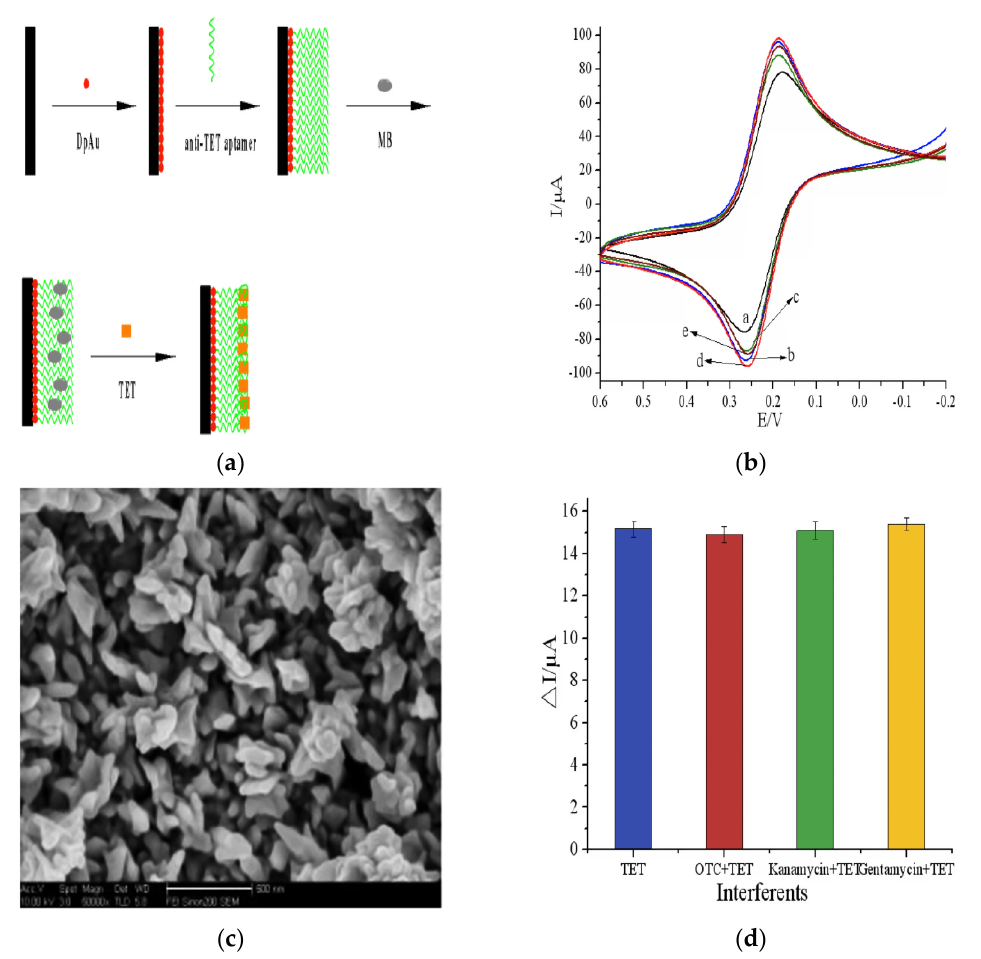
Figure 4. Methylene blue (MB)/anti-tetracycline (TET) aptamer/DpAu/glassy carbon electrode (GCE) immunosensor fabrication process ( a ), cyclic voltammograms (CVs) of different modification processes of GCE ( b ), scanning electron microscope (SEM) image of dispersed AuNPs over GCE ( c ), aptasensor specificity in the presence of different interferences ( d ). Reproduced from ESG [71].